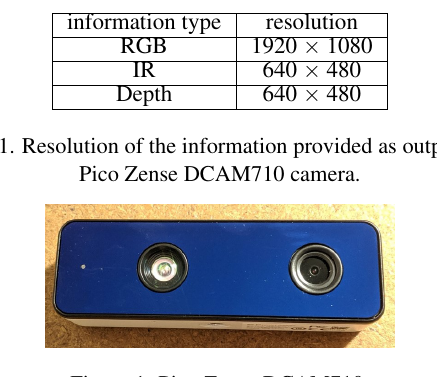
Figure 1. Pico Zense